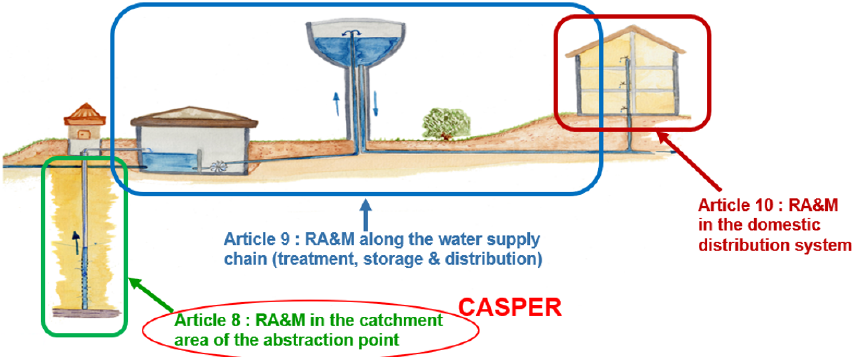
Figure 1. The three main areas developed on the new approach of Risk Assessment and Monitoring (RA&M) of groundwater quality (Source image: adapted from Tom Schaul, Ministry of Environment Luxembourg).